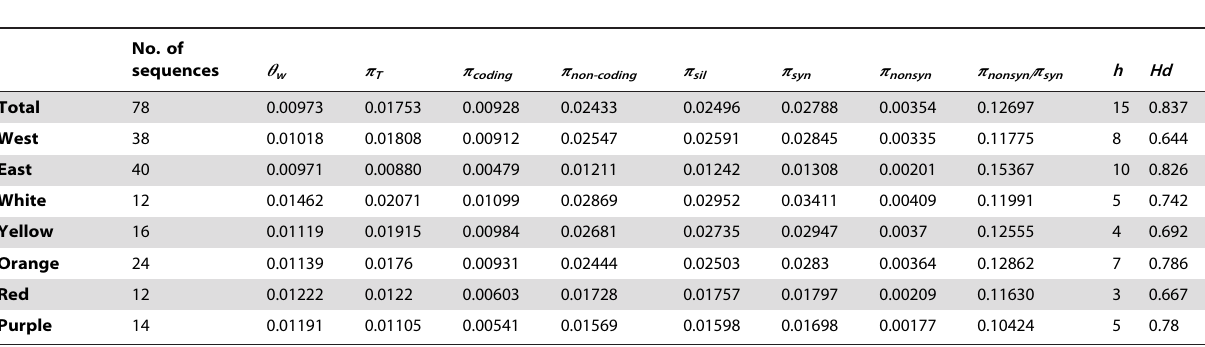
Table 4. Nucleotide polymorphism of CRTISO in a sample of 39 carrot